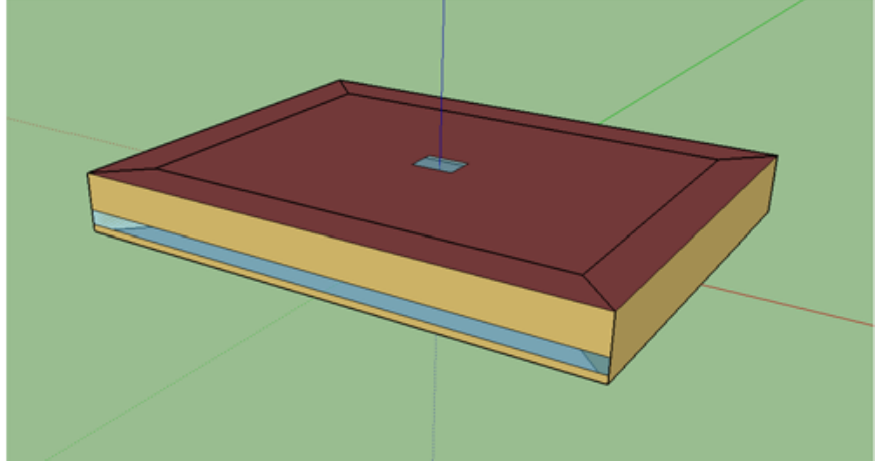
Figure 4. Simplified geometry analyzed by TSPR analysis tool for the retail standalone prototype building model.